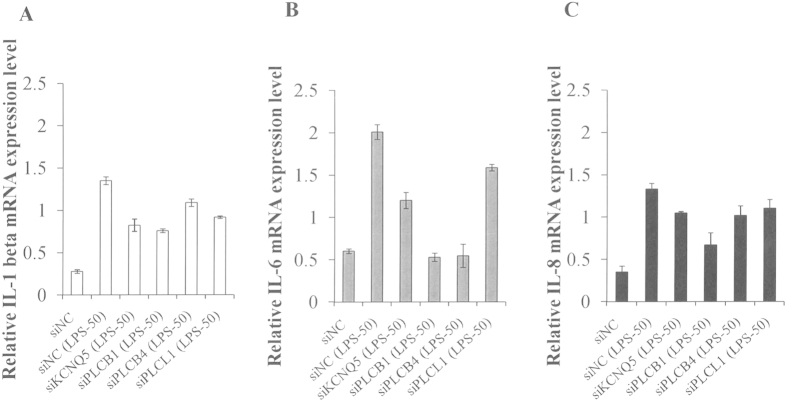
Effect of KCNQ5, PLCB1, PLCB4, and PLCL1 down-regulation on IL-1, IL-6, and IL-8 proinflammatory cytokine mRNA expression.HUVEC cells were transfected with siKCNQ5, siPLCB1, siPLCB4, and siPLCL1 or siNC for 24 h application of LPS for an additional 24 h. IL-1beta (A), IL-6 (B), and IL-8 (C) mRNA expression levels were quantified by RT-qPCR. Data represent means ± SD for three independent experiments.